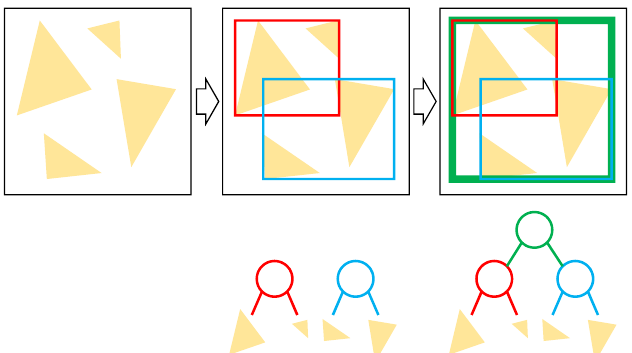
Figure 6. A simple 2D example of the bottom-up breath-first tree construction: closer objects are paired until the whole space is processed into the tree.